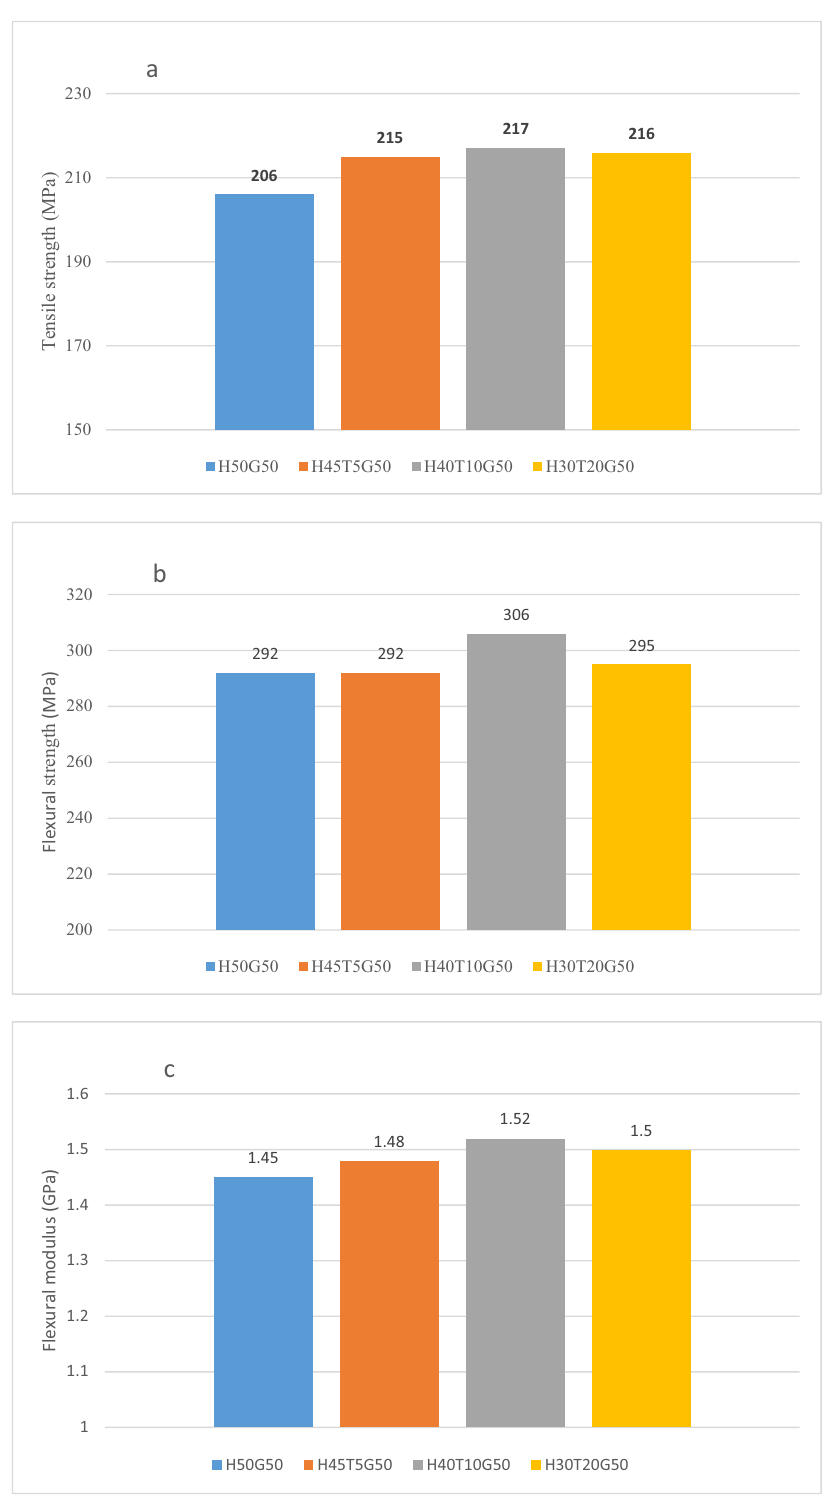
Figure 9: Tensile strength ( a ) , fl exural strength ( b ) , and fl exural modulus ( c ) of H 50 G 50 , H 45 T 5 G 50 , H 40 T 10 G 50 , and H 30 T 20 G 50